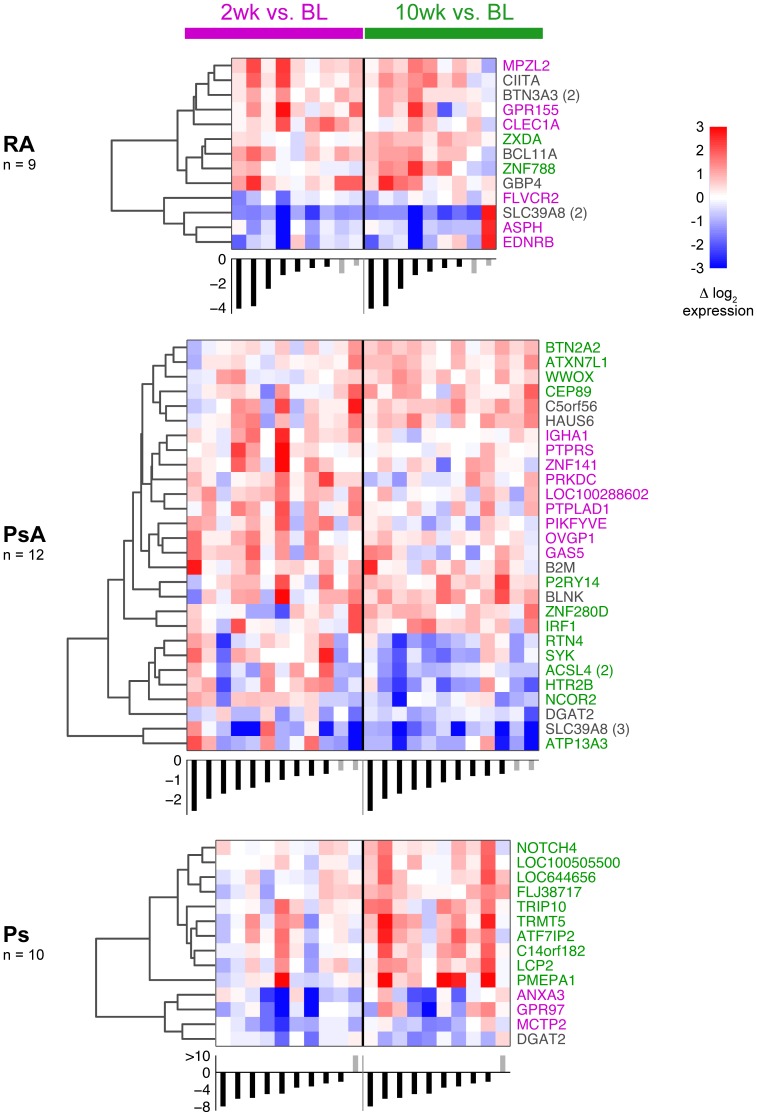
Heat map of IFX treatment effect for CD14+ cells in different diseases.In each heat map, columns correspond to patients and rows to probe sets. Separate heat maps are shown for three diseases and two cell types as indicated. Color is the log2 difference in expression at 2 or 10 weeks relative to baseline as specified by the blue and gold bars, respectively (patients are in same order for each set of columns for each disease). Probe set clustering was accomplished using Euclidean distance and complete linkage. Only genes for which p<.005 for one of the time points are shown. BL = baseline. Font color for gene names indicate whether the probe set was significant at p<.05 at 2 weeks (purple), 10 weeks (green) or both (gray). For all heat maps, the columns (patients) are sorted first by responders/non-responders, and then by change in disease activity at 10 weeks relative to baseline (DAS28 for RA and PsA, PASI for Ps), which is shown beneath each heat map (responders are black bars, non-responders are gray bars).